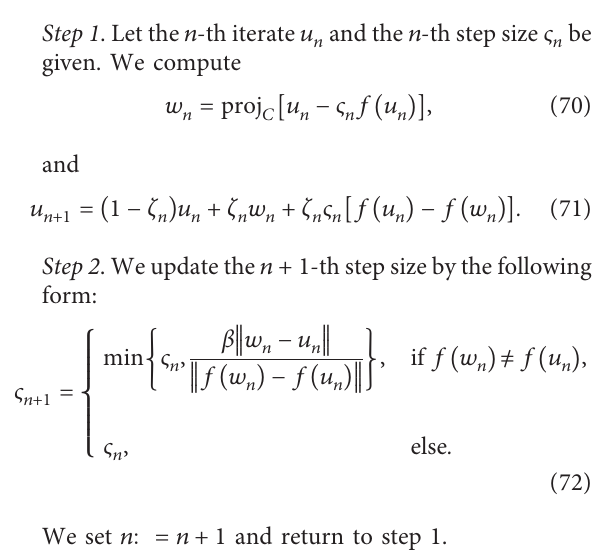
∈ H be an initial guess. We 0